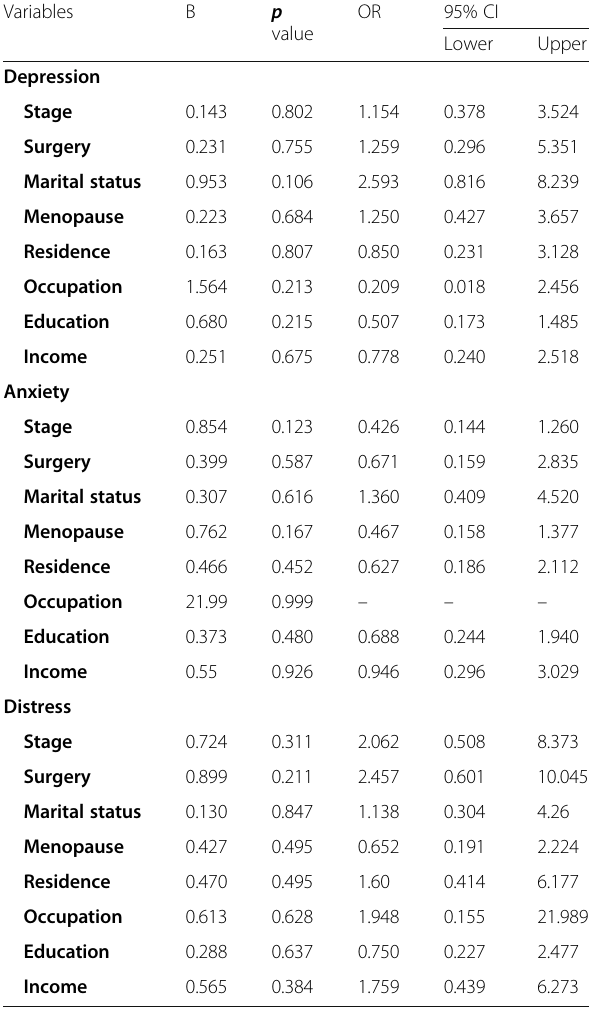
Table 6 Logistic regression analysis on factors associated with anxiety, depression, and distress among cases